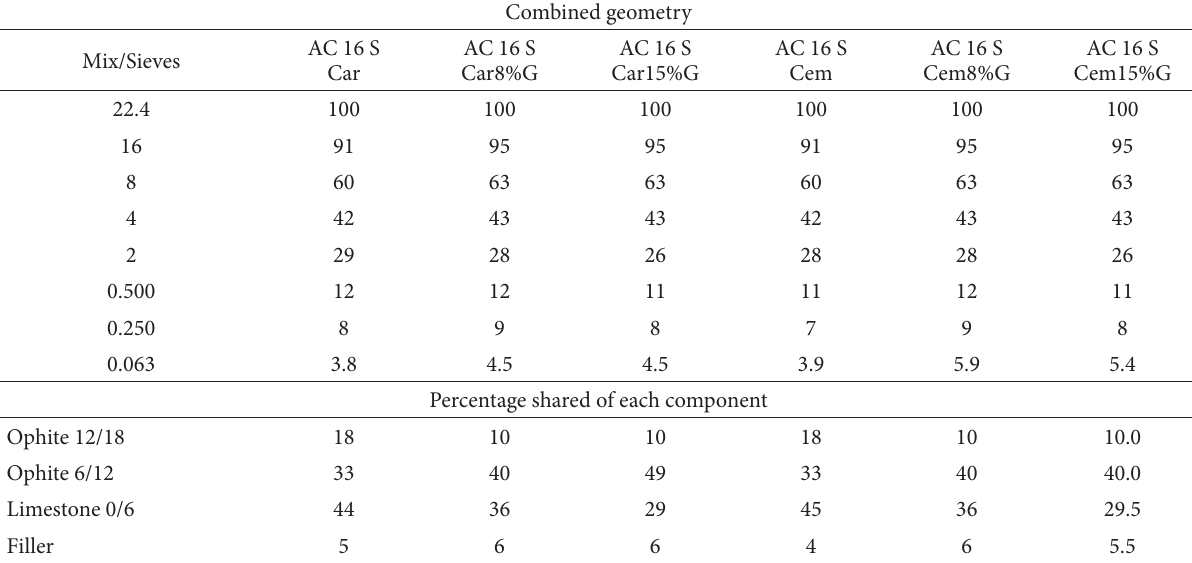
Table 3. Aggregate size and percentage shared of the job mix